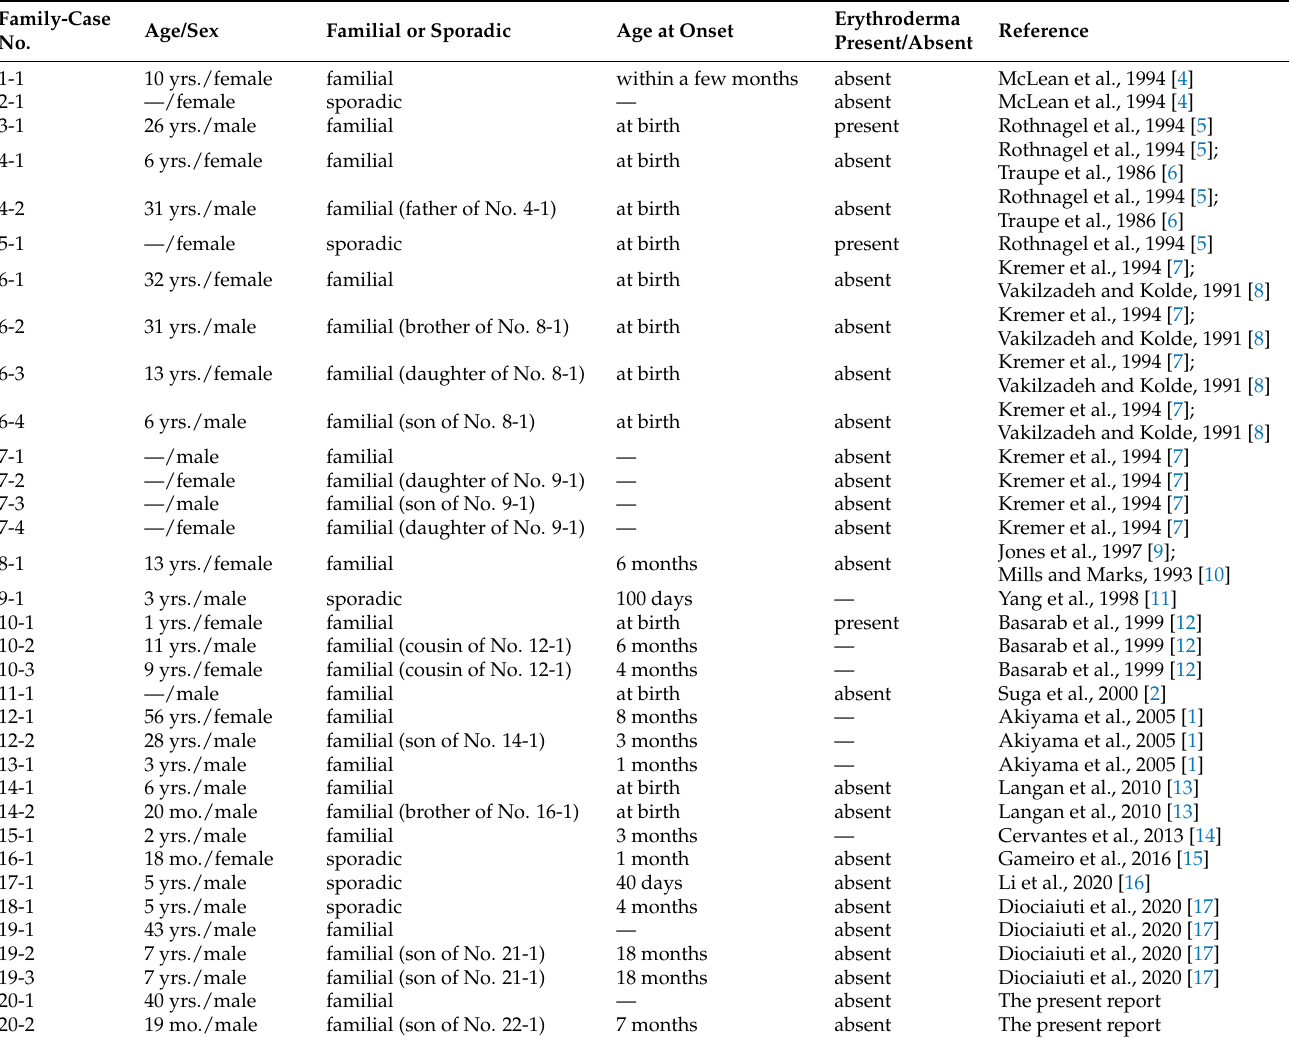
Table 1. Review of published cases of superficial epidermolytic ichthyosis with the identical mutation p.Glu487Lys in KRT2